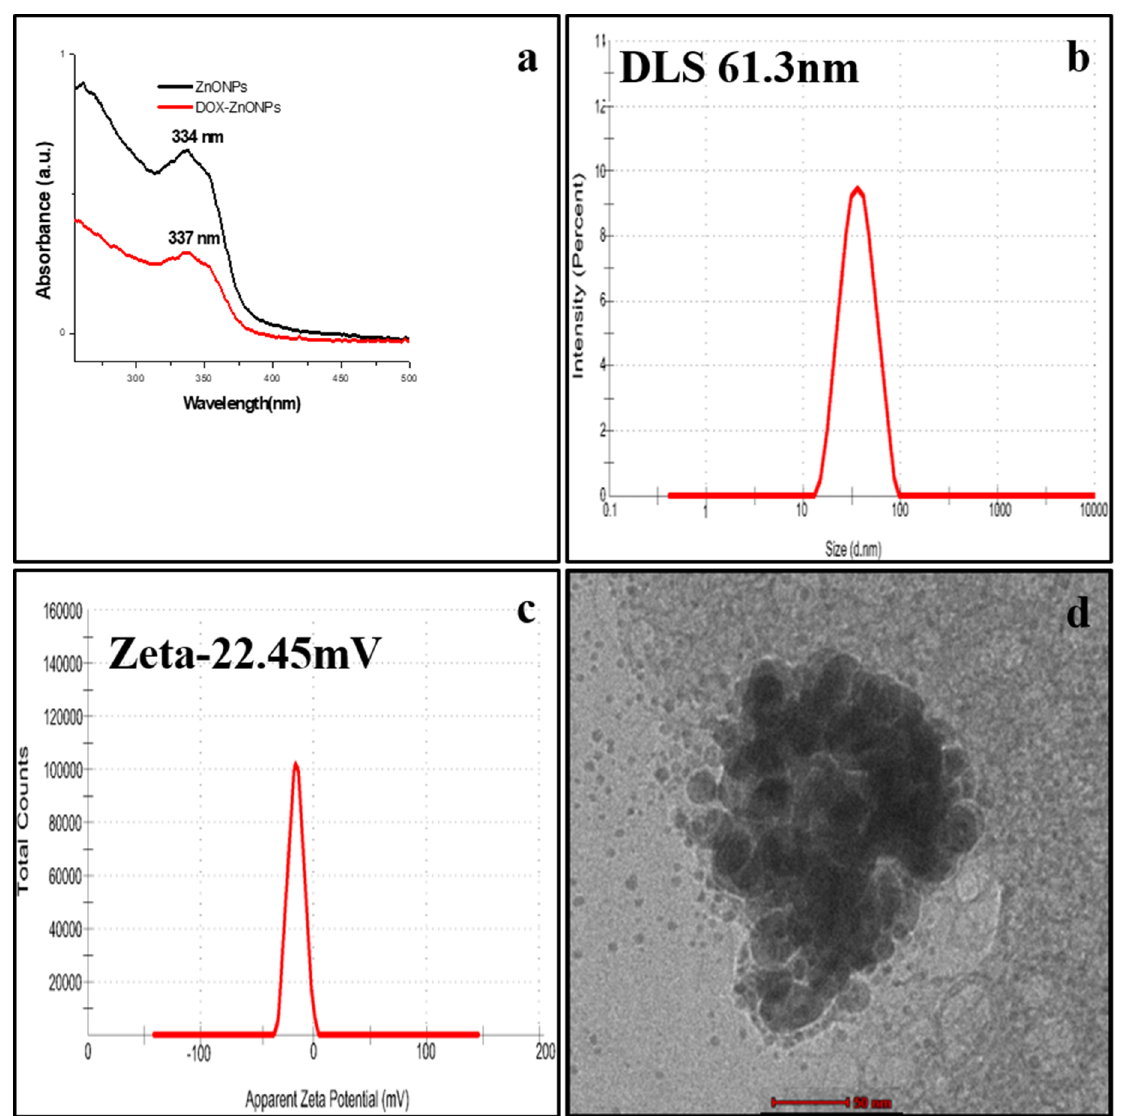
Figure 4. Characterisation of DOX-ZnONPs under ( a ) UV-Visible spectra (337 nm) ( b ) Dynamic light scattering (61.3 nm) ( c ) Zeta potential ( − 22.45 mV) and ( d ) Transmission Electron Microscopy (size 23.5 nm).